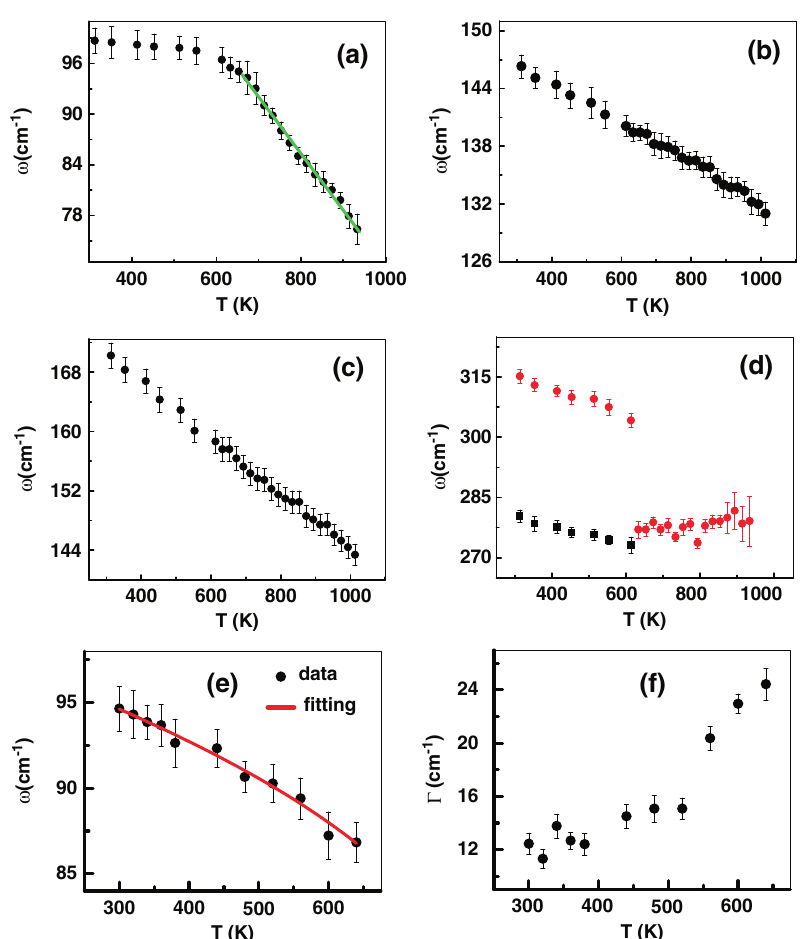
Fig. 2 Damped harmonic oscillator (DHO) model fi tting of low-frequency Raman modes. a lowest soft mode at ~97 cm − 1 using all the active Raman modes in DHO fi tting, till 600 K, it shows negligible nonlinear decrease in frequency with increase in temperature, later follows the linear behavior till fi rst phase transition temperature and above, b 147 cm − 1 Raman mode shows linear temperature-dependent nature, c 169 cm − 1 Raman mode displays linear behavior as function of temperature, d merger of 315 and 285 cm − 1 modes near 600 K, e DHO fi tting is used on only fi rst fi ve low-frequency Raman modes and their obtained data for low-frequency 96 cm − 1 soft mode with its fi tting with modi fi ed Curie – Weiss law ( solid line ), and f full width at half maximum behavior of low-frequency 96 cm − 1 soft